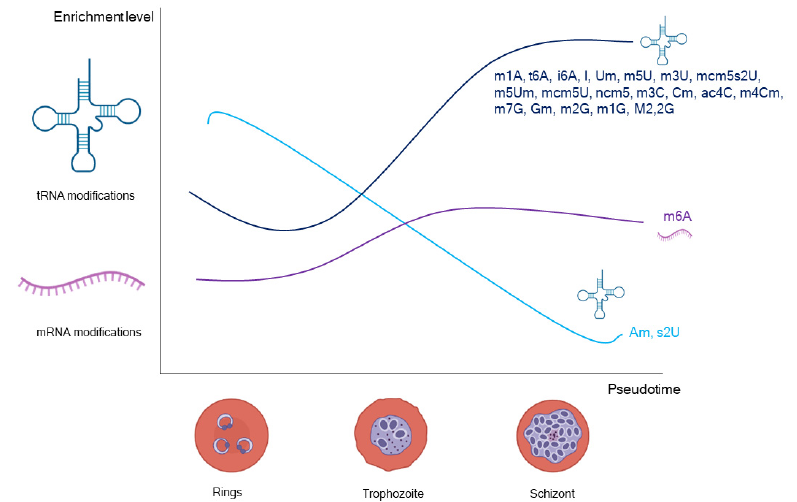
Figure 2. Dynamics of the epitranscriptomic marks through the human blood life cycle. In dark and light blue colors are depicted the tRNA modifications, mRNA modification is showed in purple. The values are not comparable across stages. The graphic is a visual representation of data extracted from Ng et al. 2018 and Baumgarten et al. 2019 [138,139]. Most of the tRNA modifications increase their abundance thorough the life cycle until the trophozoite stage. However, Am and s2U present an opposite pattern, decreasing in abundance in late stages [138]. On the other hand, the mRNA modification m6A is characteristic of late stages [139].